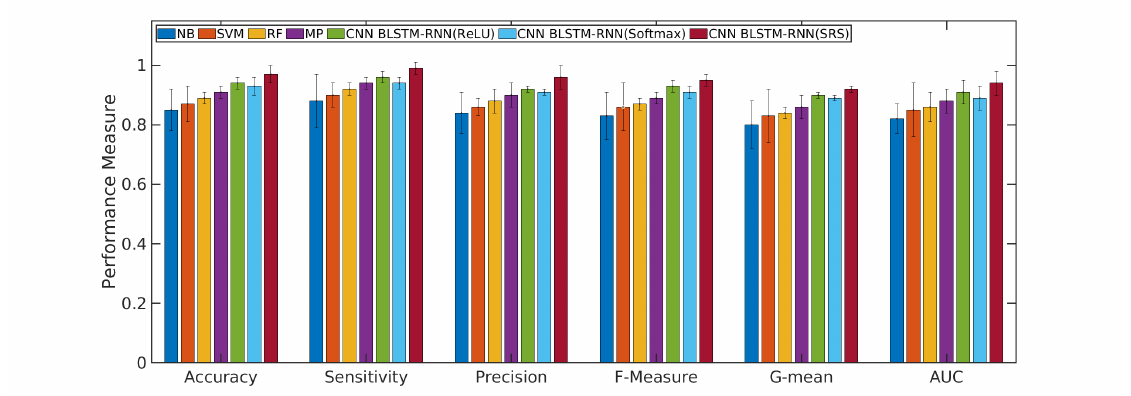
Figure 7. Results of machine learning algorithms to classify the topic of weak